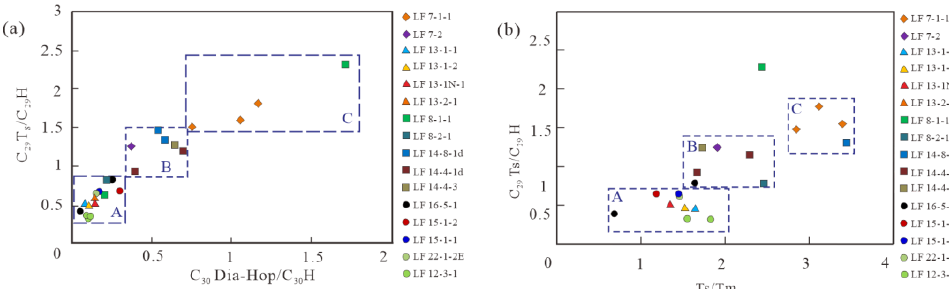
Figure 7. Comparison of parameters of biomarkers of crude oil in the southern Lufeng region: ( a ) relationship between C 29 Ts/C 29 H and C 30 Dia-Hop/C 30 H; ( b ) relationship between C 29 Ts/C 29 H and Ts/Tm.